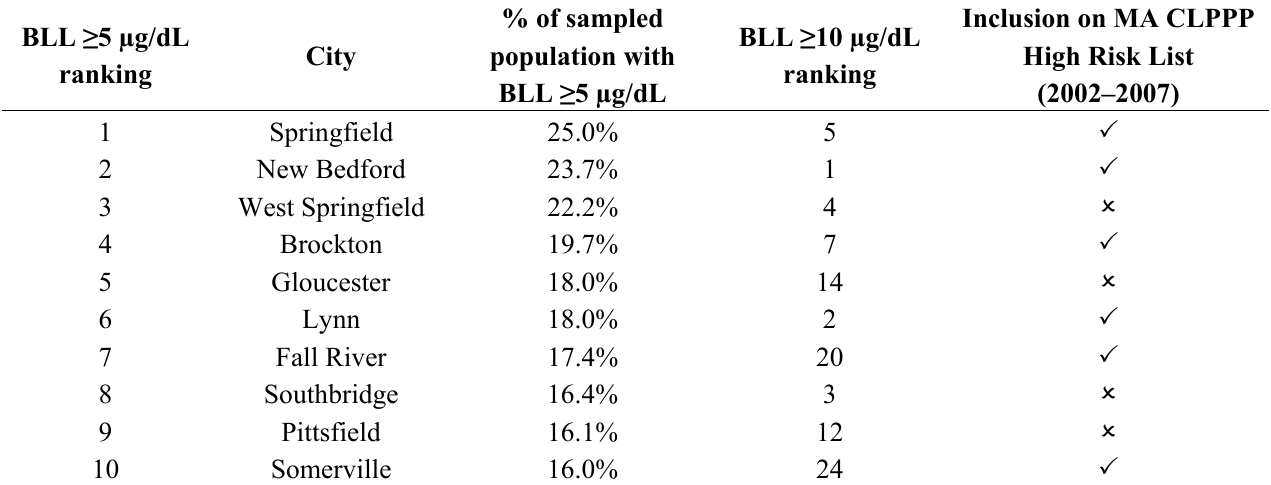
Table 1. Ten MA communities with the highest proportion of children aged 9–47 months with BLLs from ≥ 5 µg/dL in 2007, ranked by percent of population with BLLs ≥ 5 µg/dL, including the cities’ rankings under the 10 µg/dL benchmark and inclusion on the MA CLPPP high-risk